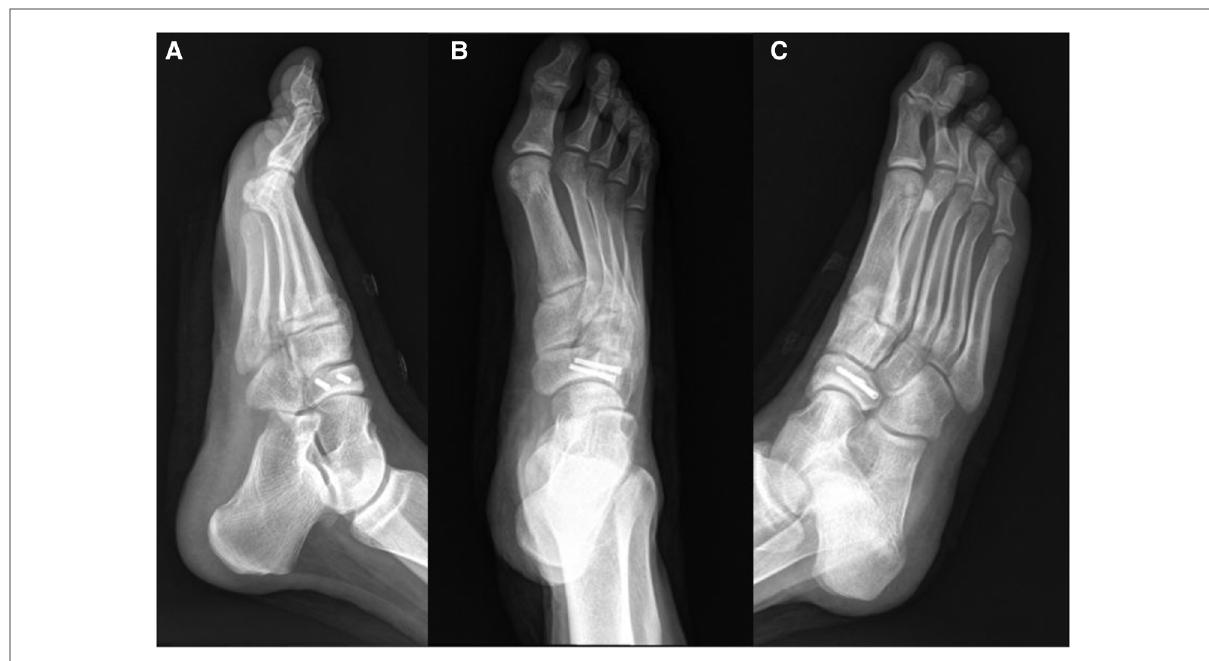
FIGURE 5 Immediate postoperative imaging data. ( A ) Non-loaded lateral x-ray of the right foot; ( B ) anteroposterior x-ray of the right foot; ( C ) oblique x-ray of the right